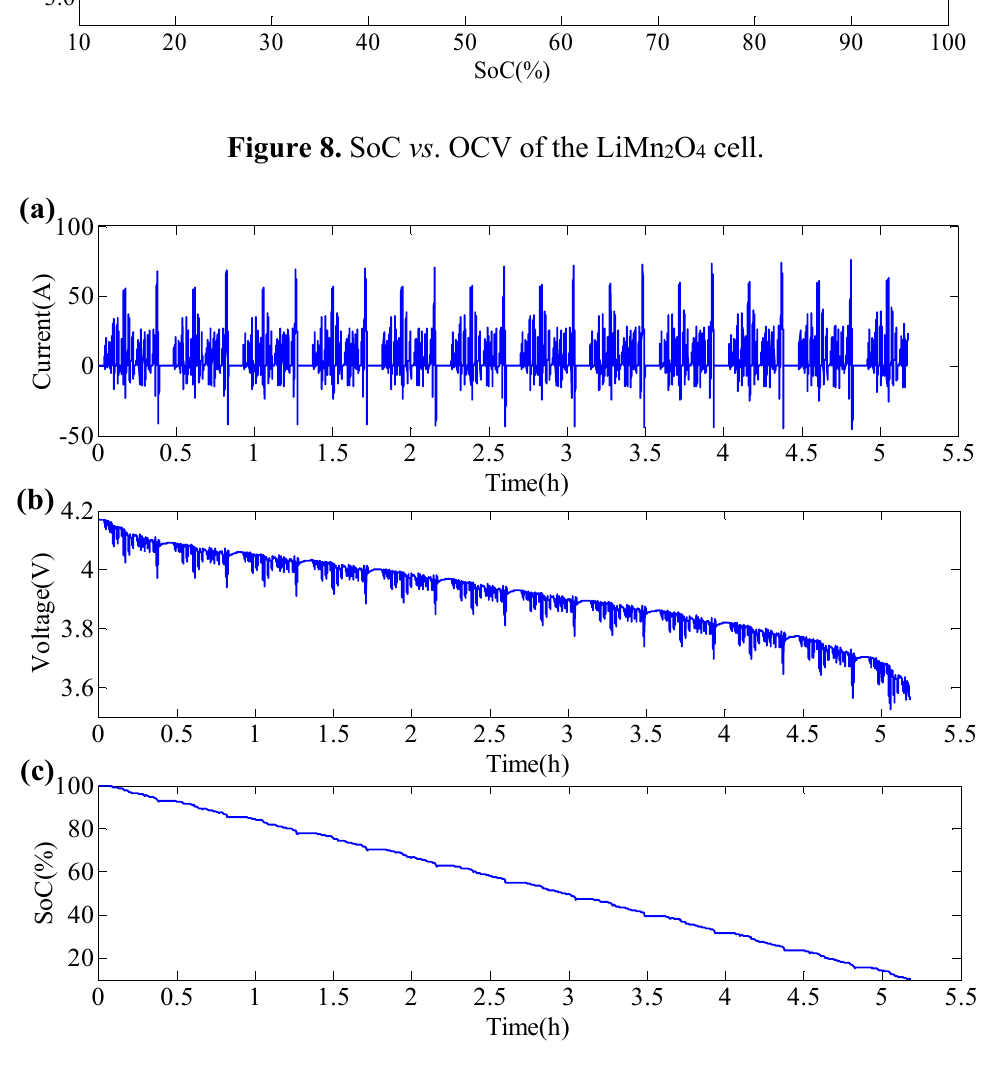
Figure 9. The Beijing Driving cycles (BJDC) test of the LiMn 2 O 4 cell: ( a ) current; ( b ) voltage; ( c )